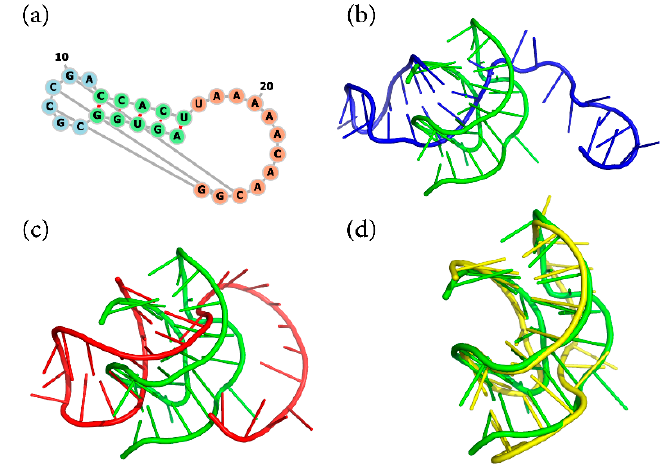
Figure 4. The secondary structure ( a ) and predicted 3D structure ( b ) of 4ADV (1410 nucleotides). The native and predicted structures are in green and red, respectively.